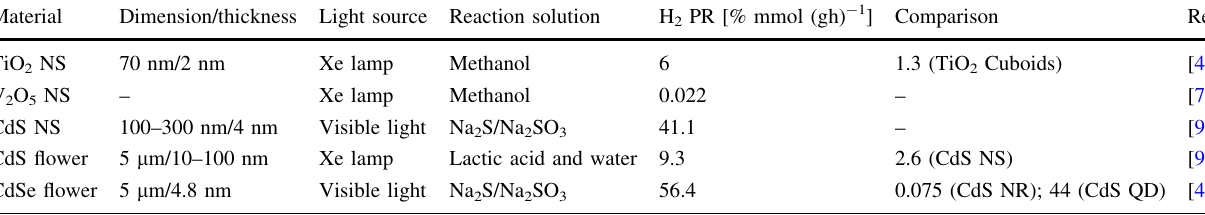
Table 1 Summary of photocatalytic H 2 evolution performance of 2D bare TMO&Cs